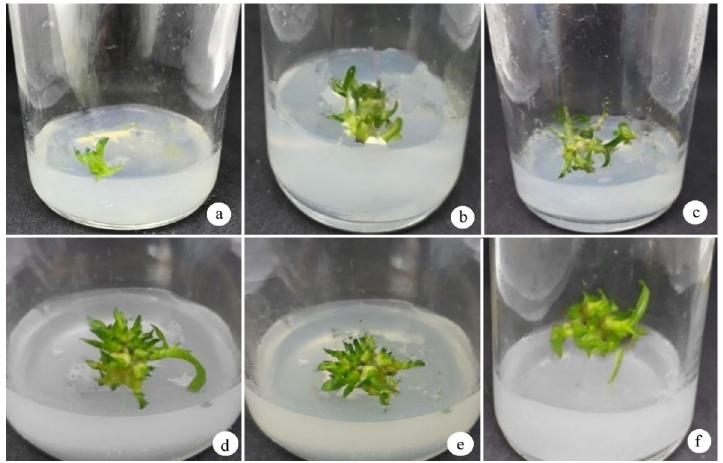
Figure 2. Effect of BA on the regeneration efficiency of the D. anosmum Lindl. protocorms (10 weeks after culturing): ( a ) MS, ( b ) MS + 0.5 mg/L BA, ( c ) MS + 1 mg/L BA, ( d ) MS + 1.5 mg/L